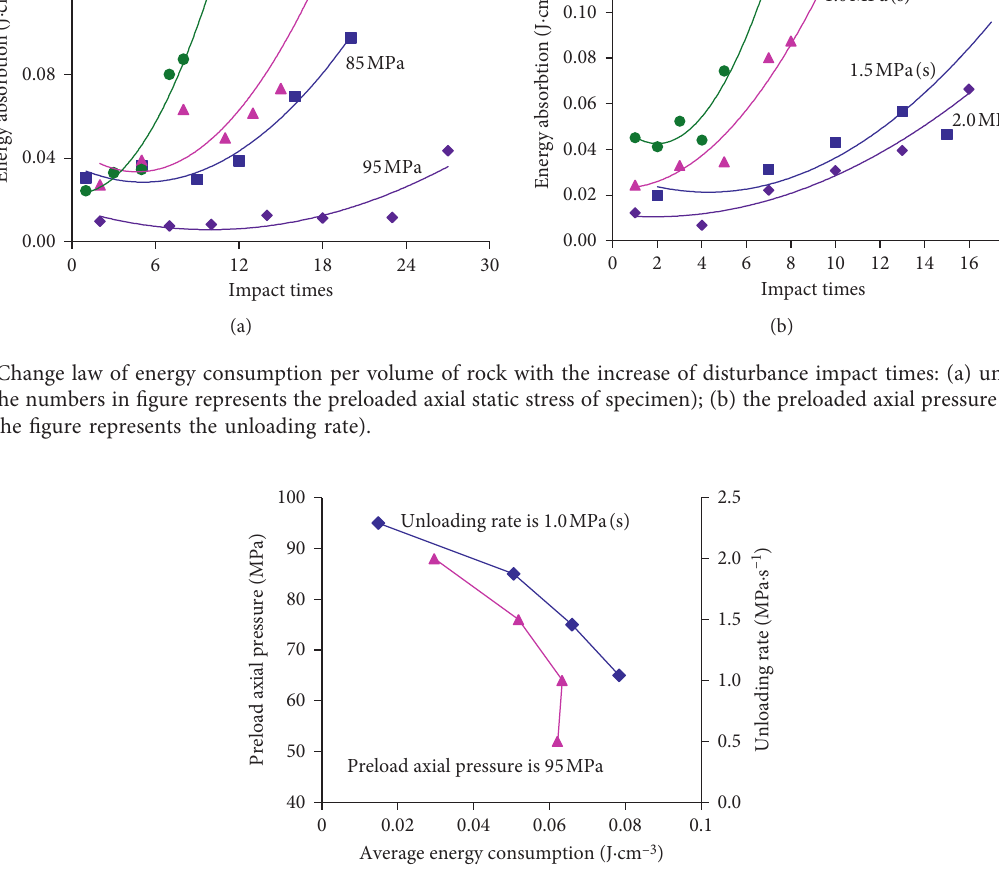
Figure 15: Change law of energy consumption per volume of rock under the influence of preloading axial pressure or unloading